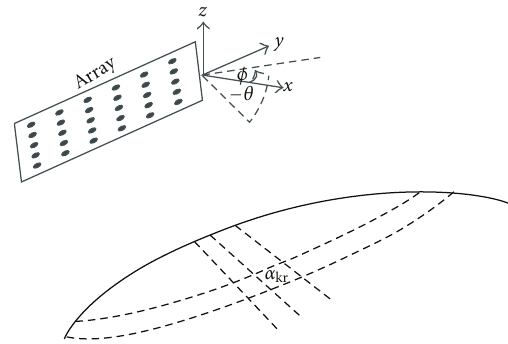
Figure 1: Airborne array with axis